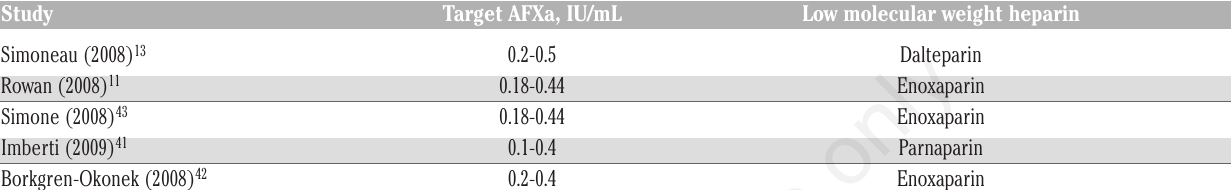
Table 3. Target anti-factor Xa ranges for thromboprophylaxis in bariatric patients.